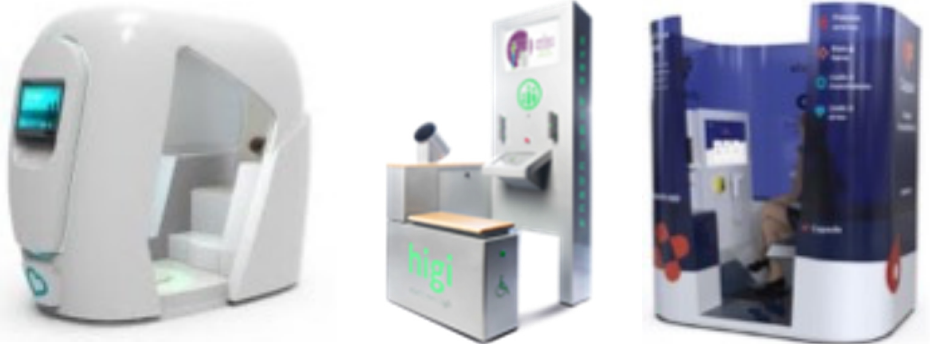
Figure 1. Example of kiosks: Bodyo ( left ), Higi ( center ) and CAPSULA ( right ).